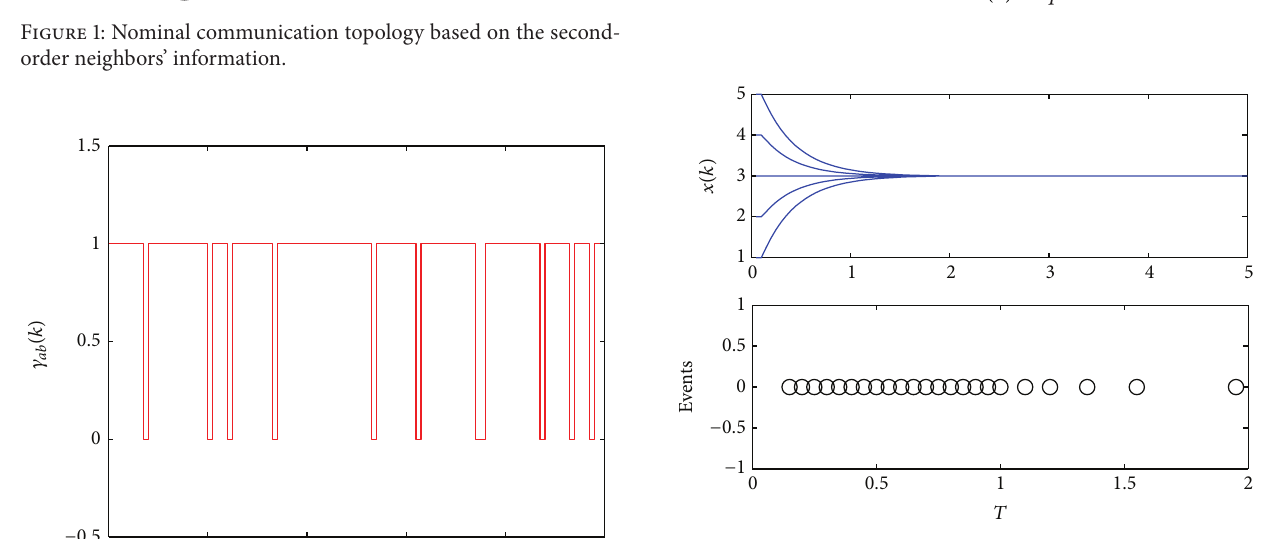
Figure 5: Protocol (26) for 𝑝 = 0.9 and 𝜏 = 0.025